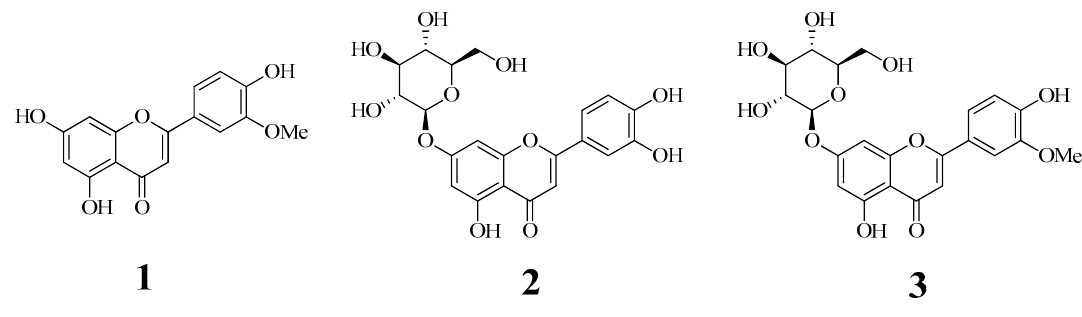
Figure 1. The structure of flavonoid derivatives ( 1 – 3 ). Table 1. The soluble epoxide hydrolase (sEH) inhibitory activities and enzyme kinetics of flavonoids. The Inhibitory Activity on sEH